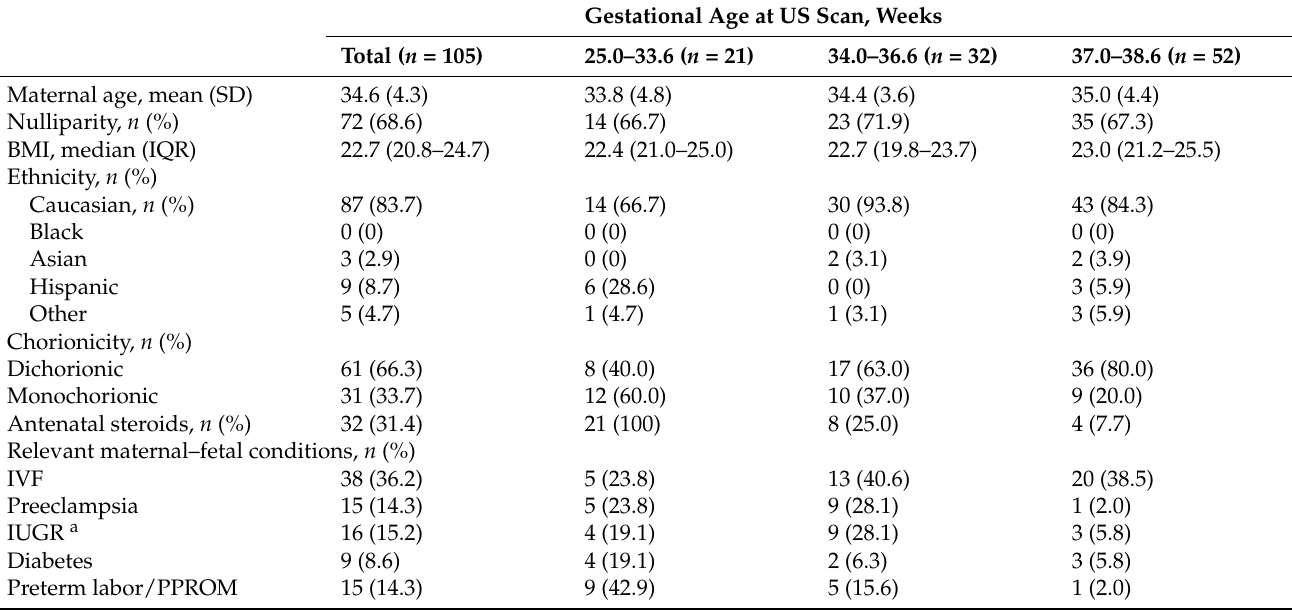
Table 1. Baseline characteristics of women included in the study.